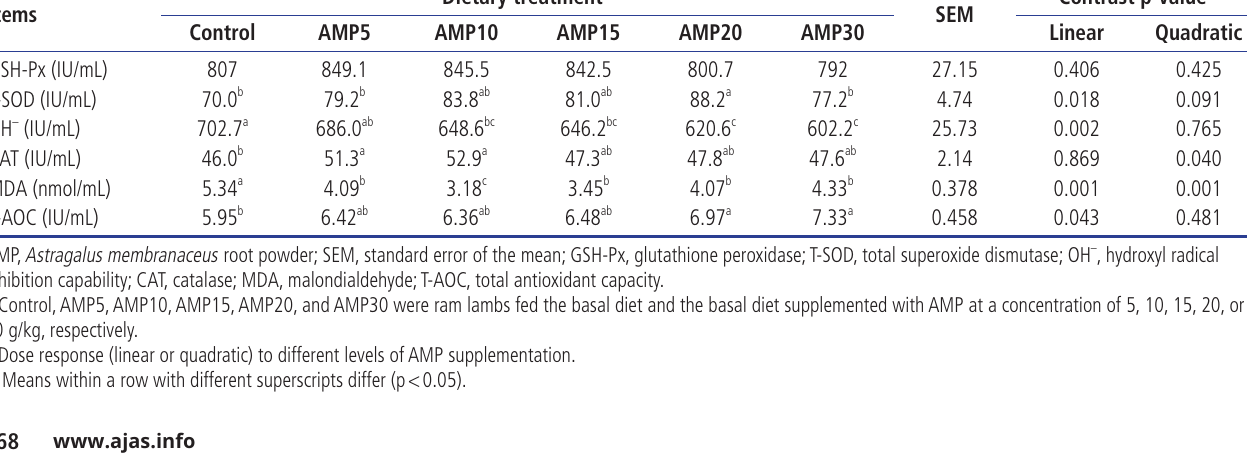
Table 4. Effects of the Astragalus membranaceus roots supplementation on antioxidant function of ram lambs